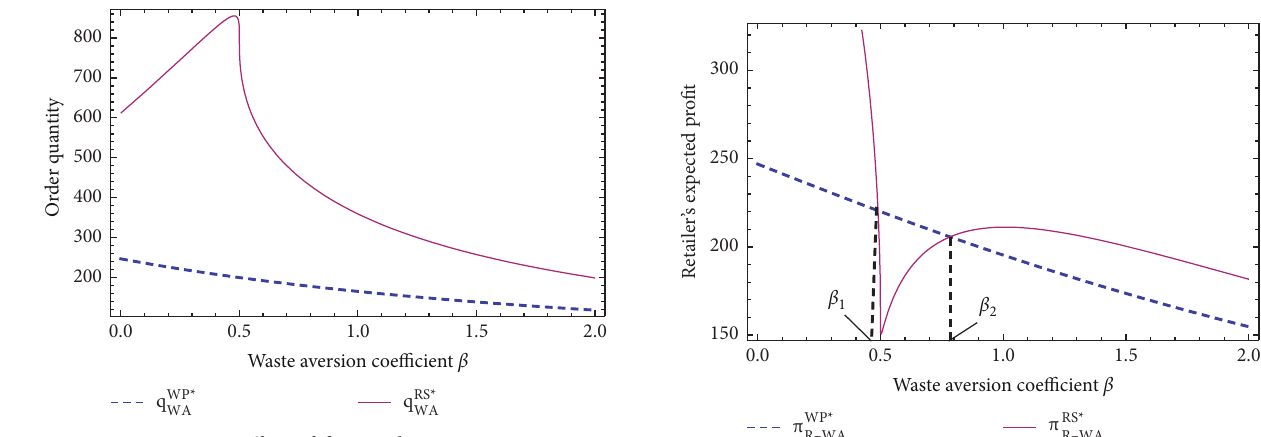
Figure 5: Effect of β on order quantity.